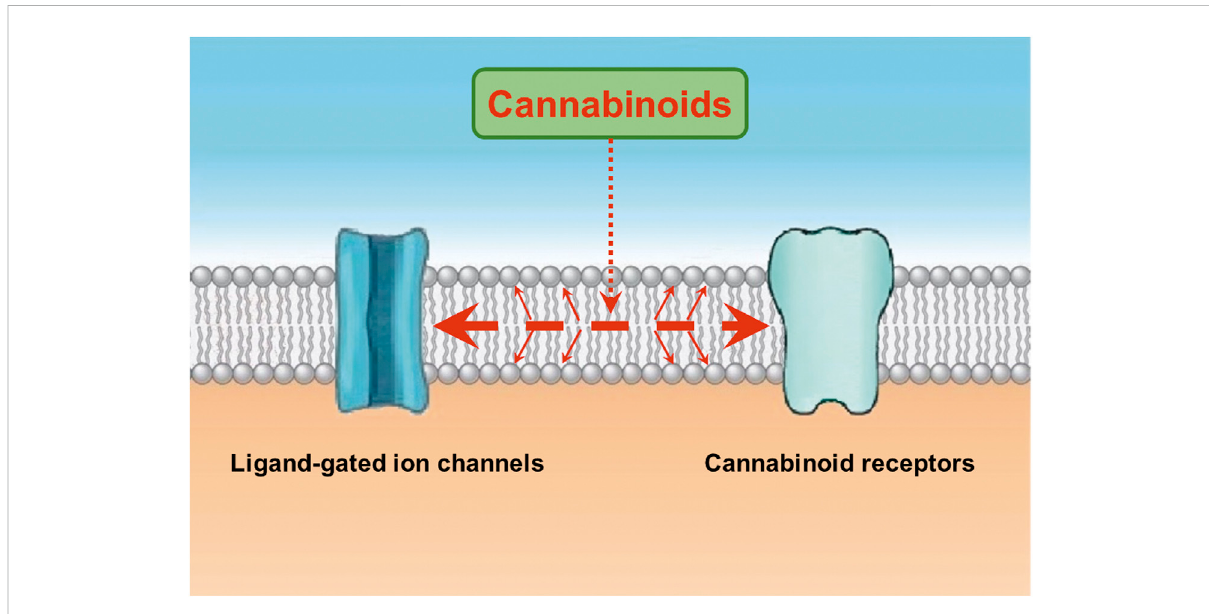
FIGURE 1 Cannabinoids interact with the lipid membrane and in fl uence the functional properties of ion channels and other integral membrane proteins. Cannabinoidsenterthelipidmembraneandbindstocannabinoidreceptorsthroughlipidmembrane(ReggioandTraore,2000;Barnett-Norrisetal., 2005; Makriyannis et al., 2005). In addition, cannabinoids directly affect channel function by changing the biophysical properties of the lipid membrane or binding to a hydrophobic binding site(s) located on the transmembrane regions of ligand-gated ion channels (represented with large dashed red arrow). Cannabinoids, like other lipophilic molecules, partition into the lipid bilayer and alter the biophysical properties of the membrane by reducing membrane electrical resistance, increasing membrane fl uidity, changing membrane order, increasing membrane stiffness, increasing membrane elasticity, and changing physicochemical and structural properties of bilayer membranes (represented with thinner diagonal red arrows). Secondly, cannabinoidscan bind directly to transmembranedomains of ion channels embedded in the cell membrane (see